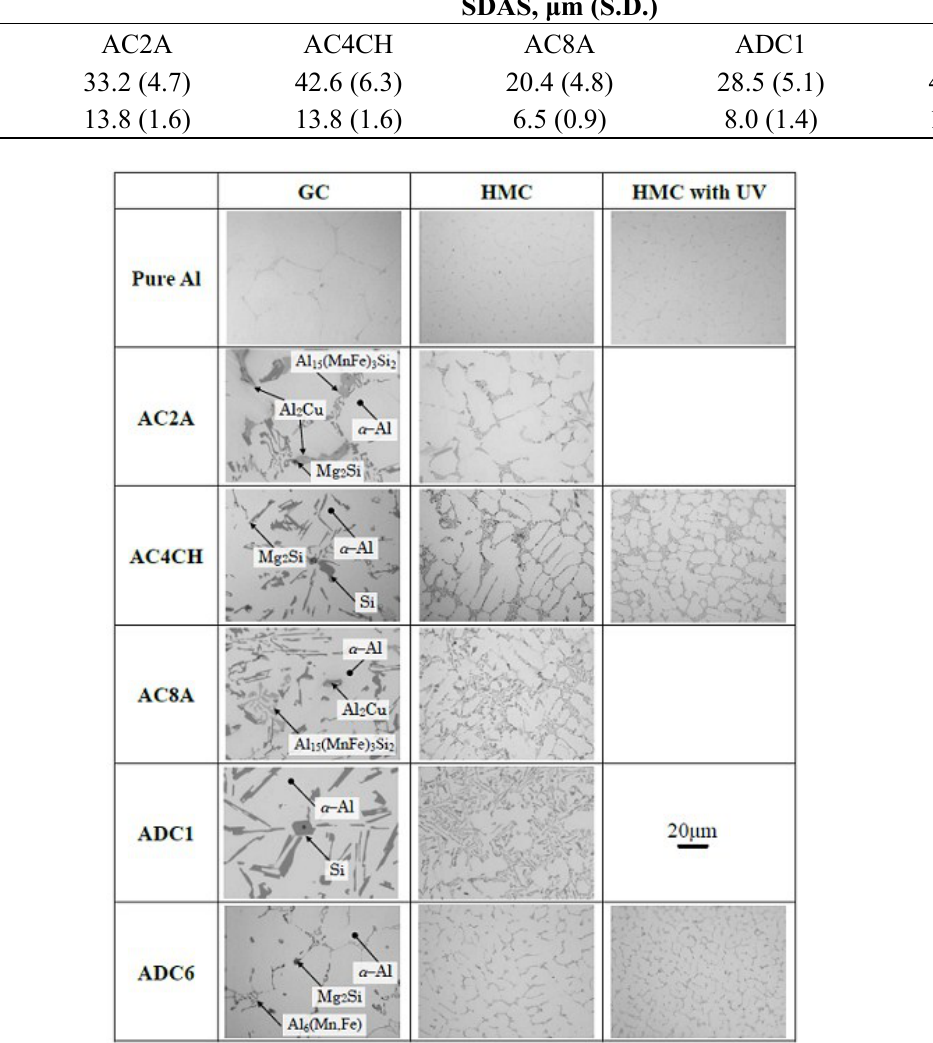
Figure 2. Optical micrographs of cast aluminum alloys. HMC = heated mold continuous casting; GC = gravity